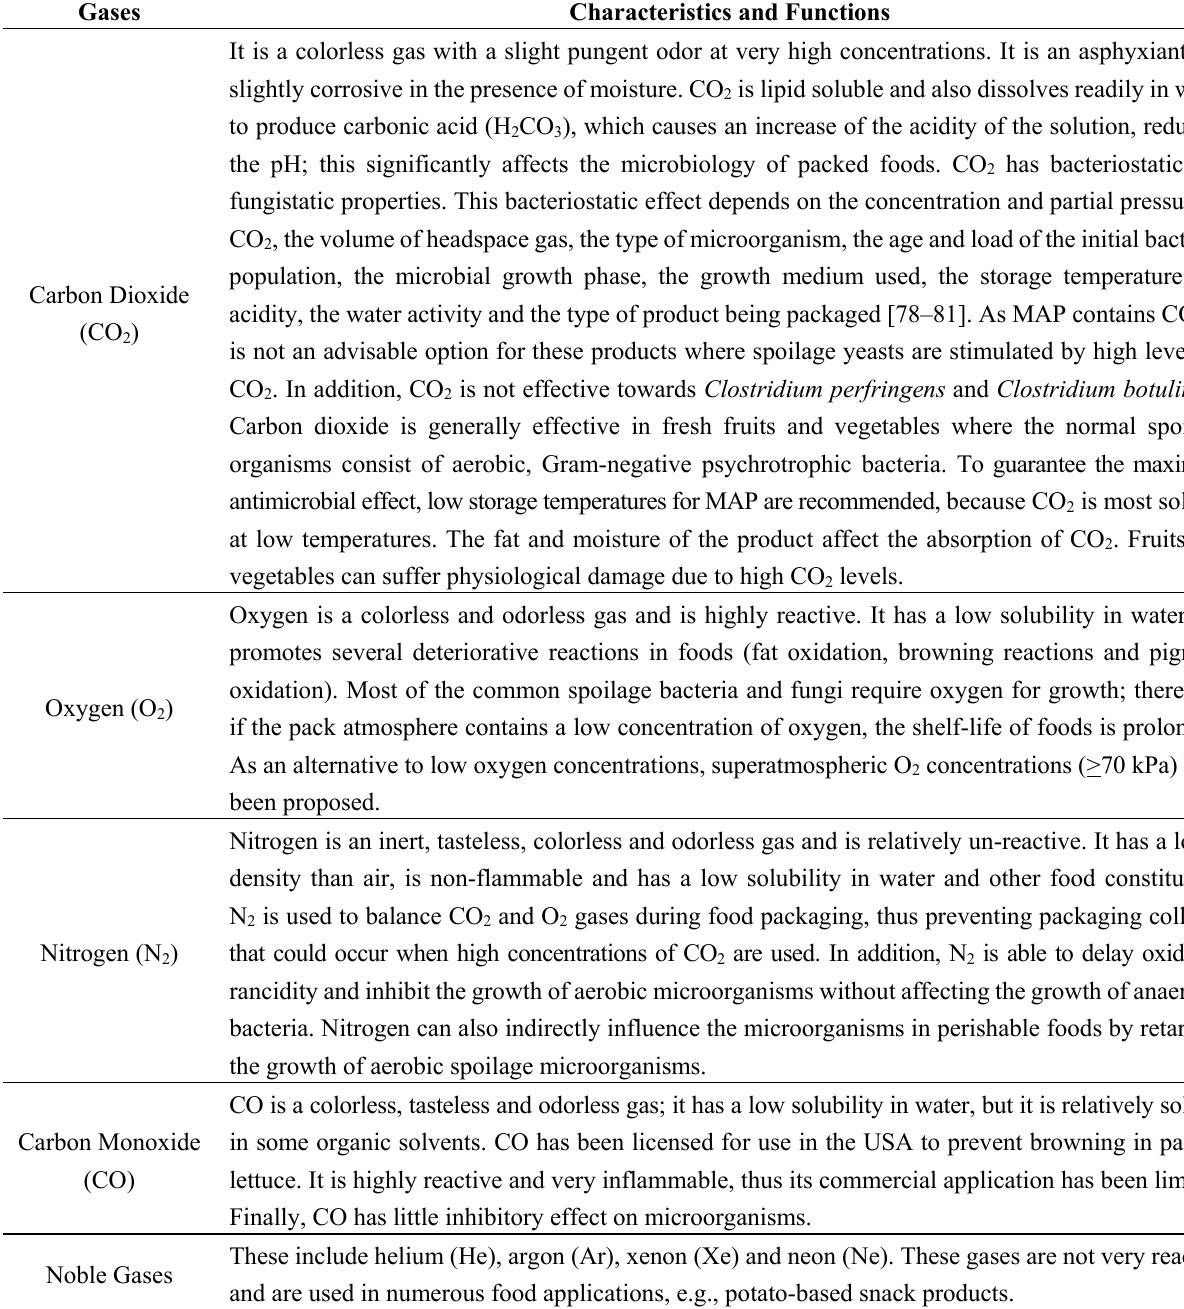
Table 2. Main gases used in